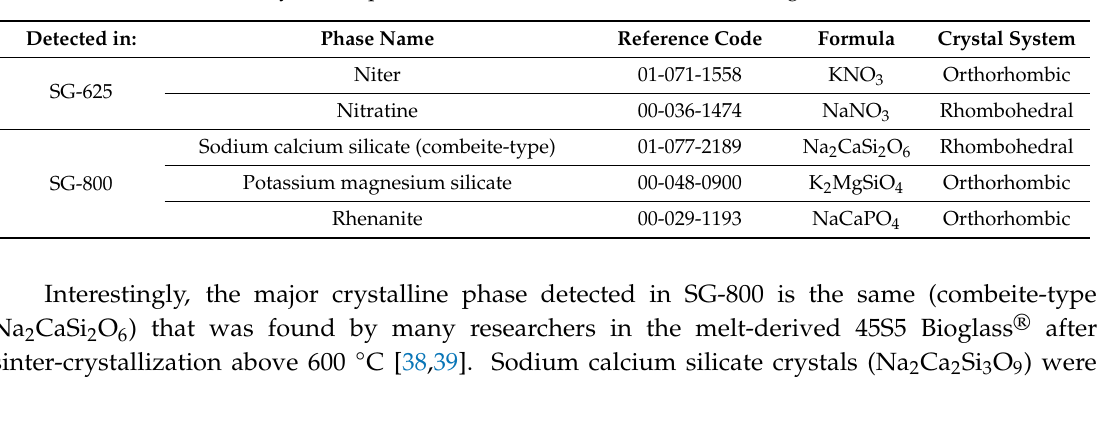
Table 1. Crystalline phases detected in SG-625 and SG-800 sol-gel